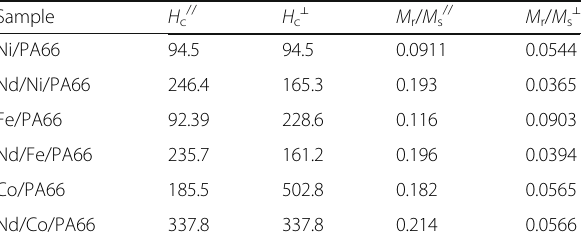
Table 2 Magnetic parameters, coercivity ( H c ), and residual magnetization ratio ( M r /M s ) of the nanostructures with the field applied parallel (//) and perpendicular ( ⊥ ) to the long